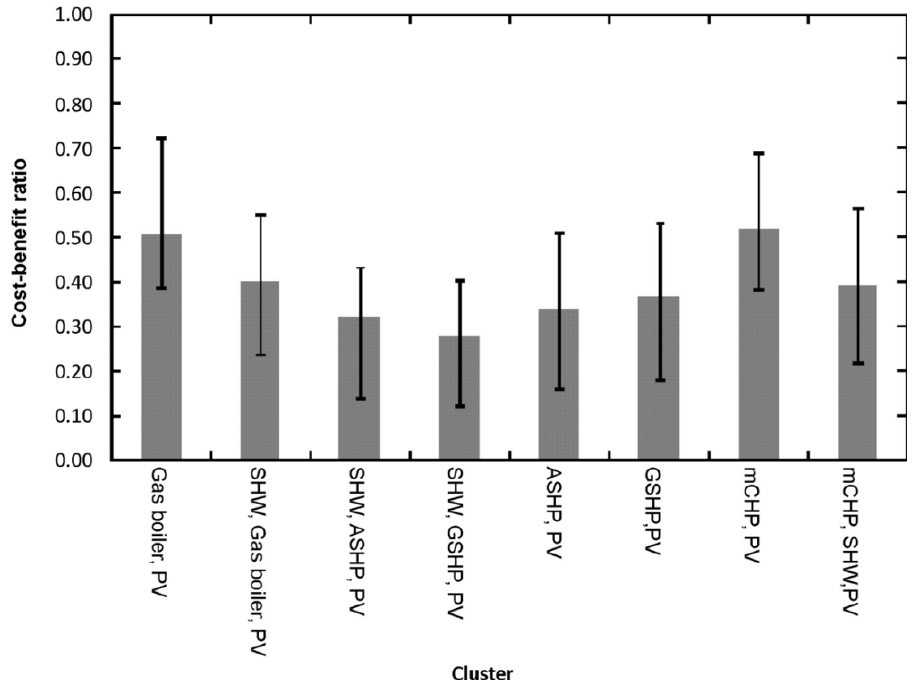
Figure 16. Discounted cost-benefit ratios for a range of clustered micro-generators. Source: Allen et al. [21].